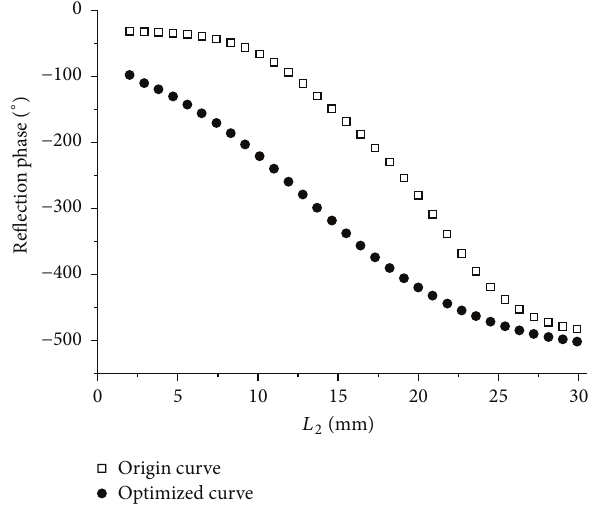
Figure 5: A comparison of the origin and the optimized reflection phase curve.